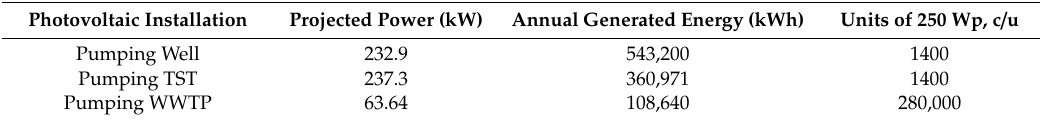
Table 2. Summary of the calculation of the solar photovoltaic installations. Source: Own elaboration. Photovoltaic Installation